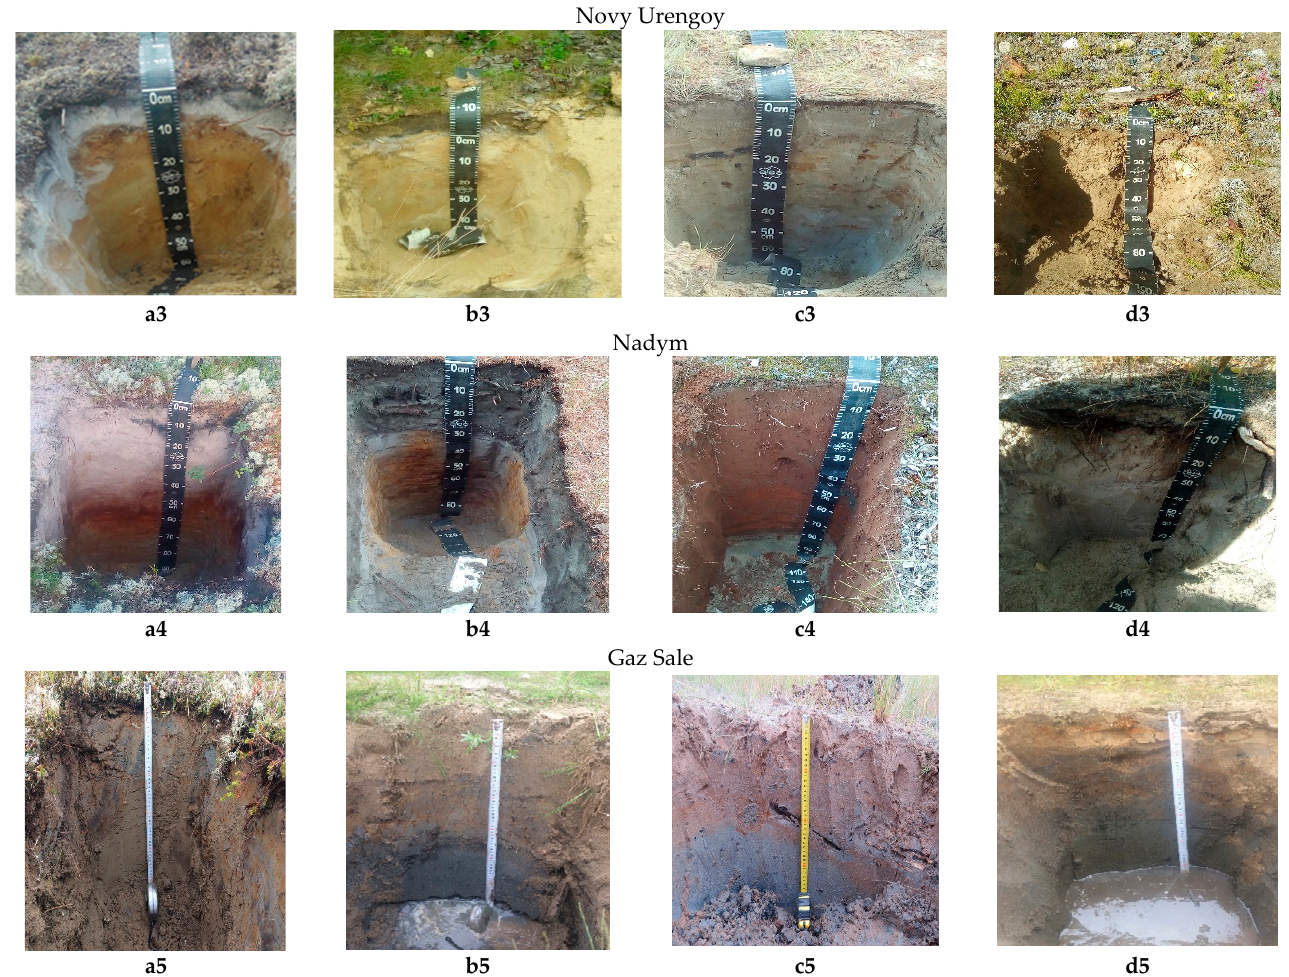
Figure 2. Soil diversity in the study cities and functional zones ( a1 – a5 —mature; b1 – b5 —residential; c1 – c5 —park; d1 – d5 — industrial).